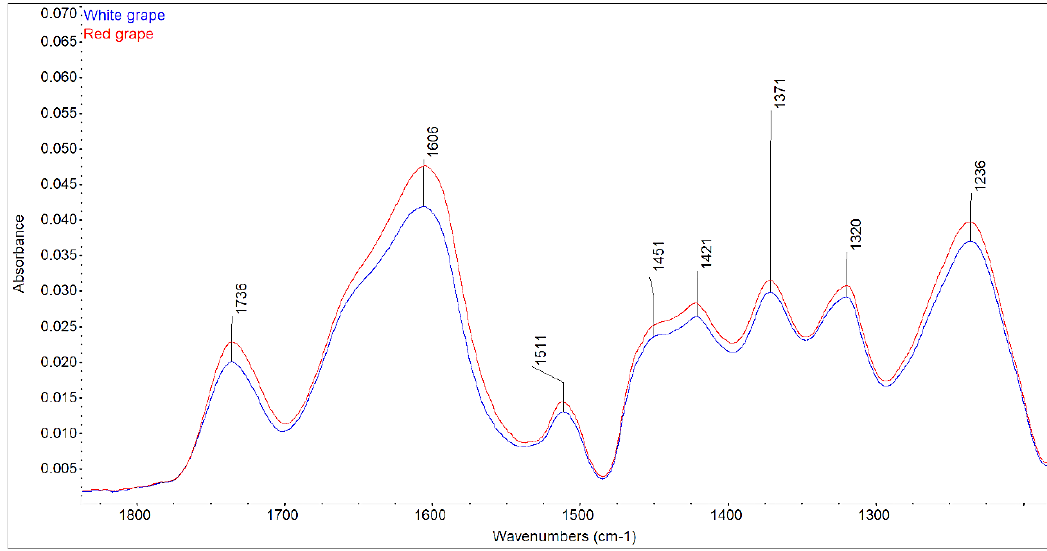
Figure 3. FTIR spectra of white and red grape samples in the fingerprint region.